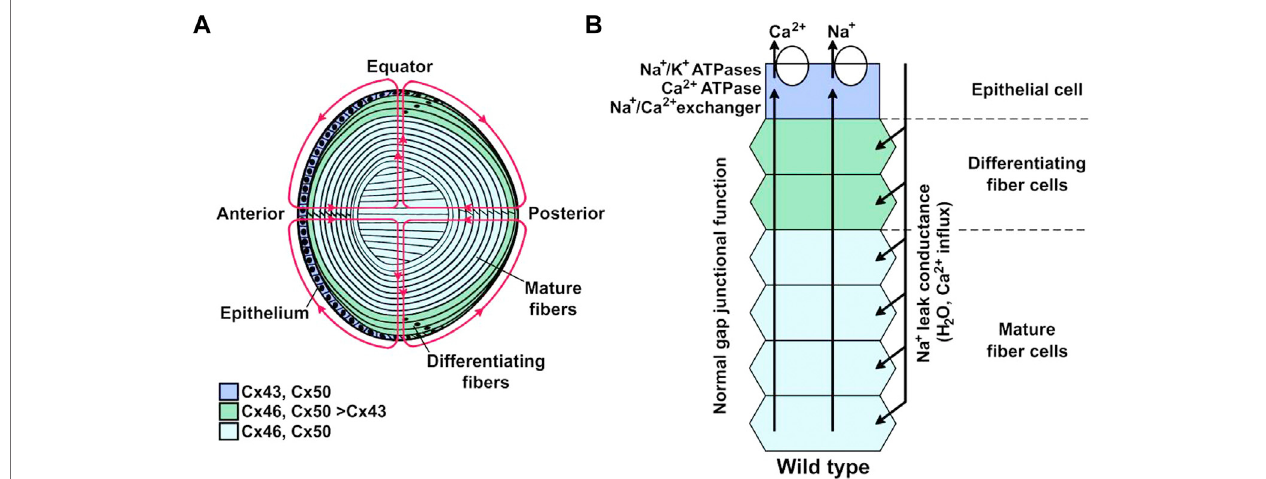
FIGURE2 | Lens internal circulation. (A) Schematic representation ofthe lens and its internal circulation. Ions and fl uid enter the extracellular spaces at the anterior and posterior poles and leave through the epithelial cell membranes at the equator. The colors indicate the expression of the predominant connexin isoforms in different regions. Cells from the anterior epithelium express Cx43 and Cx50; differentiating fi ber cells express Cx43, Cx46, and Cx50; mature fi ber cells express Cx46 and Cx50. (B) Representationoftheioncirculationandsomeofthecomponentsthatsupportionmovementsfromthelenscoretoitssurface.Na + andCa 2+ thatenterthelens at the anterior and posterior poles move to the center through the extracellular spaces where in fl ux into fi ber cells is driven by their electrochemical gradients across the membranes.Theymovetowardsthelenssurfaceattheequatorthroughgapjunctionchannels,asthecouplingconductanceishighestattheequator,wheretheseions are extruded from the epithelial cells. Ion movements generate transmembrane osmotic gradients that couple their movement to that of fl uid. Reproduced with permission from the Int. J. Med. Sci. 21(16):5822 (Berthoud et al., 2020).